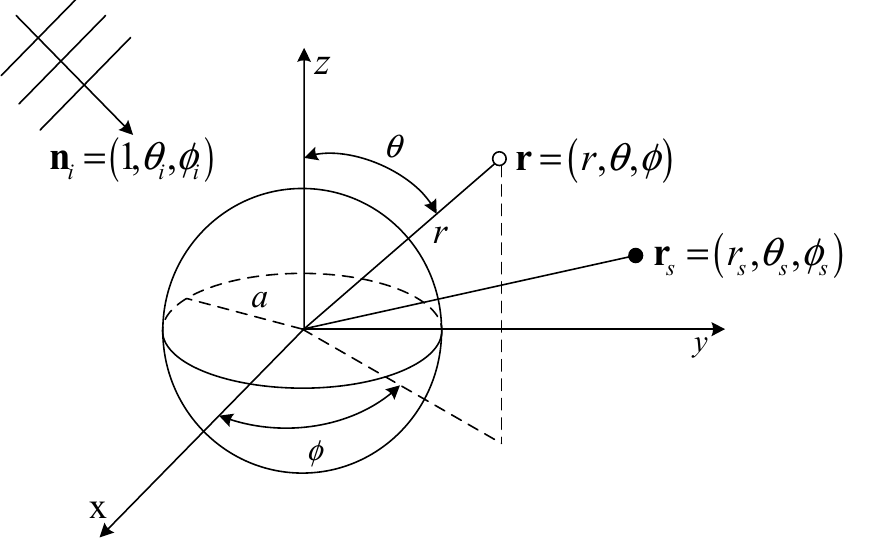
Figure 1. Coordinate of the rigid sphere.